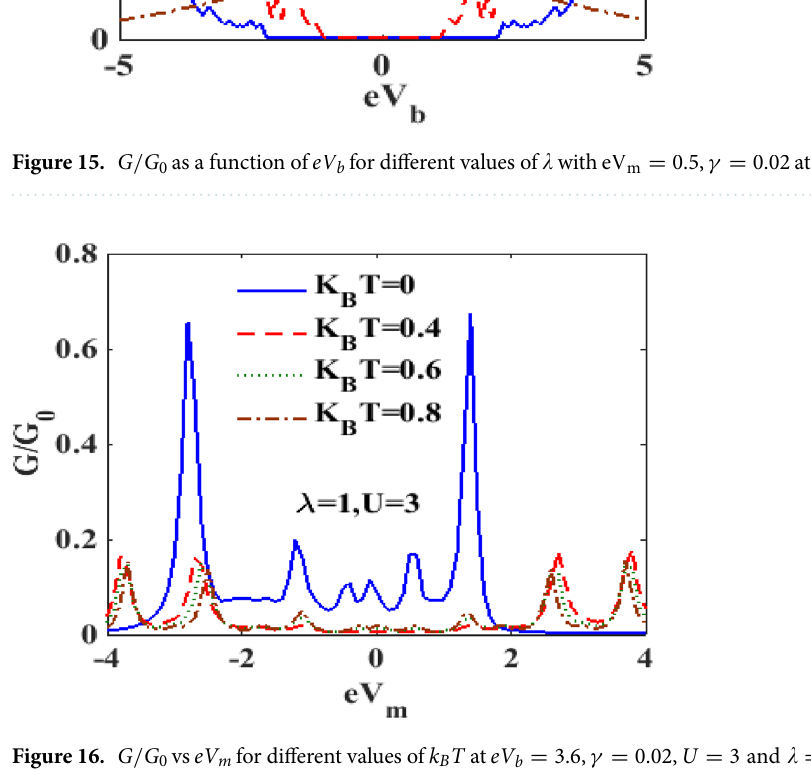
Figure 16. G / G 0 vs eV m for different values of k B T at eV b = 3.6, γ = 0.02, U = 3 and (cid:31) = 1 .